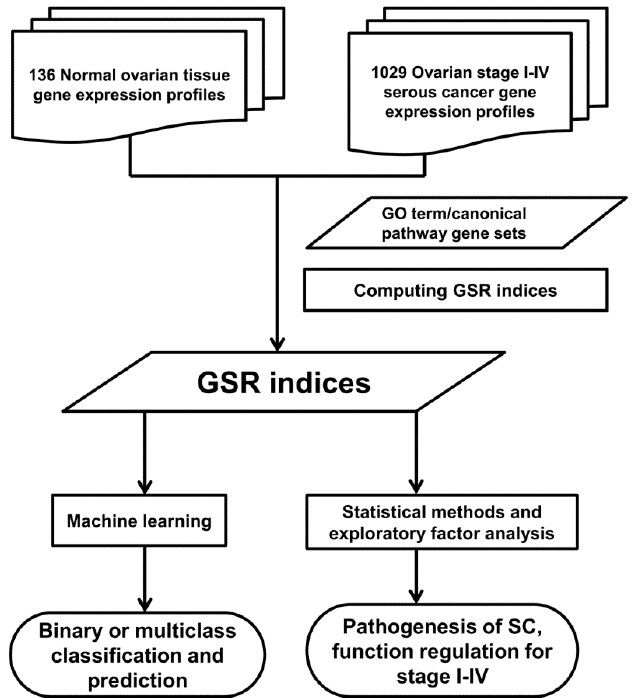
Figure 1. Workflow of the gene set regularity model. The gene set regularity (GSR) index was computed by converting the gene expression ordering of each sample in each group using the gene ontology (GO) term or canonical pathway gene set. A machine-learning algorithm was trained to recognize the patterns consisting of the GSR index matrices and then executed the binary (each stage vs. control group) or multiclass (stage I to IV + control groups) classifications. The functionome analyses were performed to investigate the pathogenesis of ovarian serous carcinoma (SC) using statistical methods, hierarchical clustering and exploratory factor analysis.